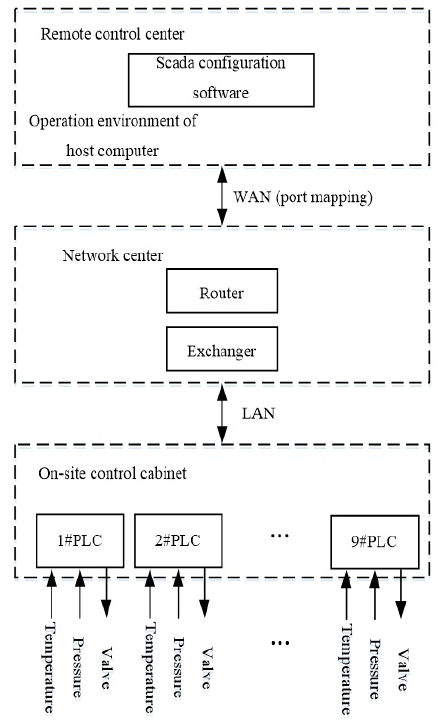
Fig. 2 System structure chart.